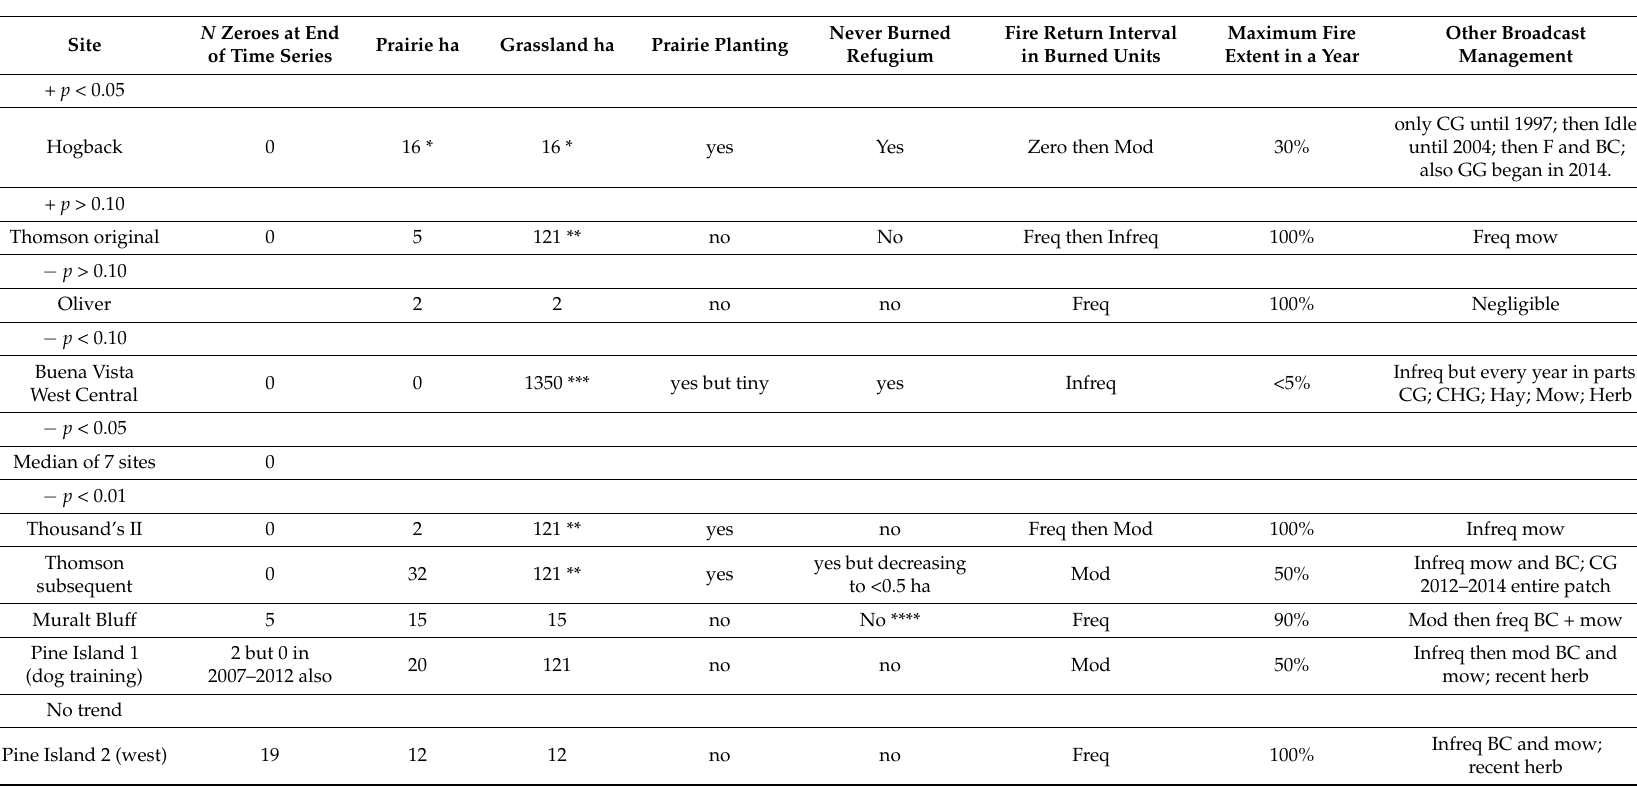
Table 11. Characteristics of sites analyzed for trend during 1997–2015 (Table 5). Sites are listed from most positive (+) to most negative ( − ) trend, with the trend of the median abundance for these sites (negative at p < 0.05, per Table 10) also indicated. The bottom site has no calculated trend because no regal fritillaries were recorded there during this period. N Zeroes at End Prairie ha Grassland ha Prairie Planting of Time Series